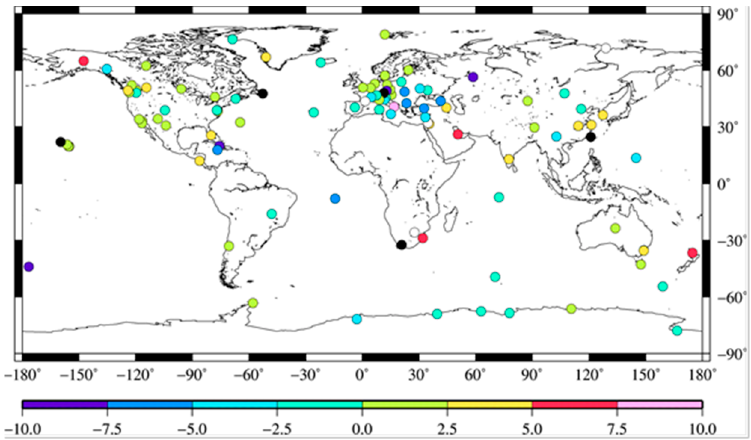
Figure 5. The S1/S2 induced long-term velocity variation rate with respect to the latitude. From top to bottom are the N, E, and U components. The unit of the variation rate is in percentage (%).